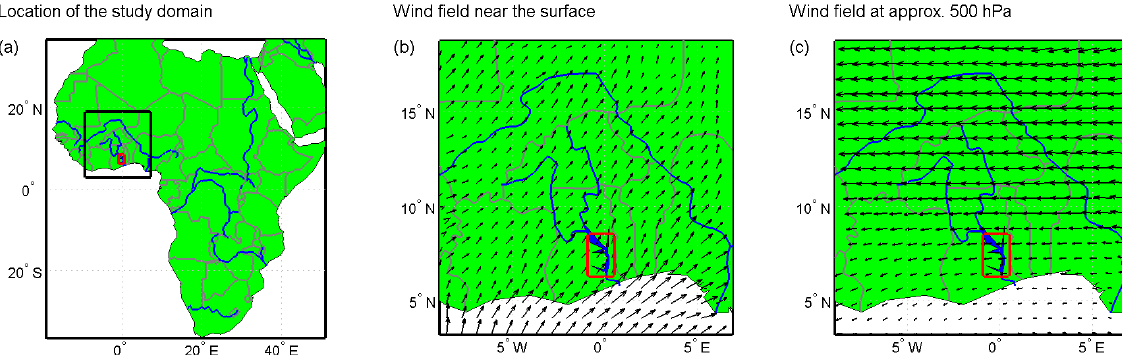
Fig. 1. Study domain and wind fields at different heights (arrows) averaged over August 1998 according to the MM5 model run. (a) location of the study domain (black rectangle) within Africa, (b) the wind field near the surface, and (c) the wind field at a model layer which corresponds to approximately 500hPa or 5km. Rivers and Lake Volta are shown in blue, country borders in grey and the tagging source area lies within the red rectangle. Note that in the text the tagging source area is sometimes referred to as Lake Volta, but actually covers some of its surroundings as